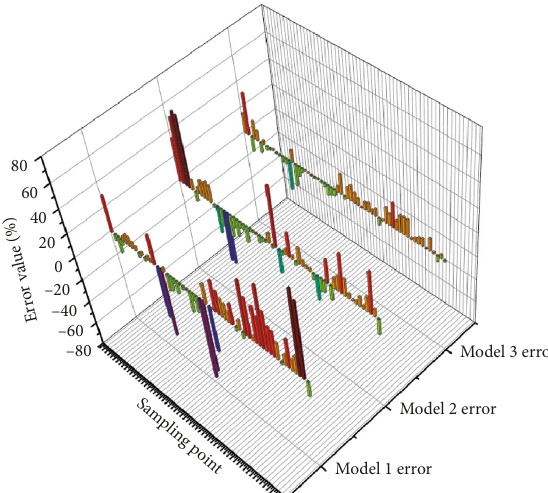
Figure 3: Comparison of prediction results.